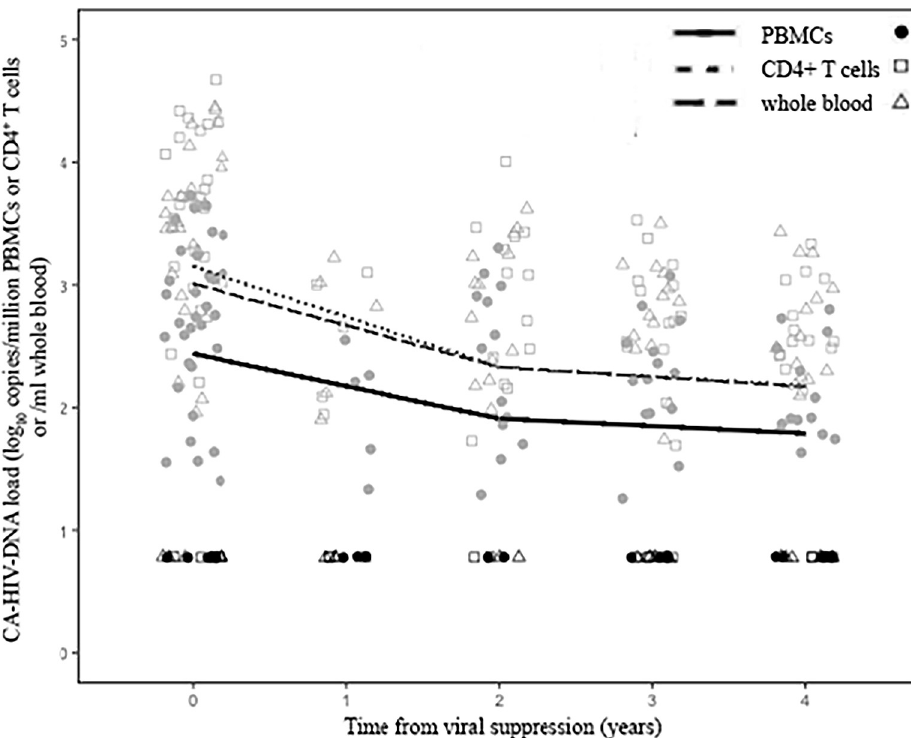
Fig 2. Decay rates of CA-HIV-DNA from children with sustained viral suppression according to the compartment analyzed. Individual lines indicate the trajectories of CA-HIV-DNA based on the model prediction. Individual points represent the quantification of HIV-1 DNA from each patient at specific time points. Levels of CA-HIV-DNA expressed as log 10 cpm PBMC for PBMC, log 10 cpm CD4 + T cells for CD4 + T-cells, and log 10 copies/ mL whole blood for whole